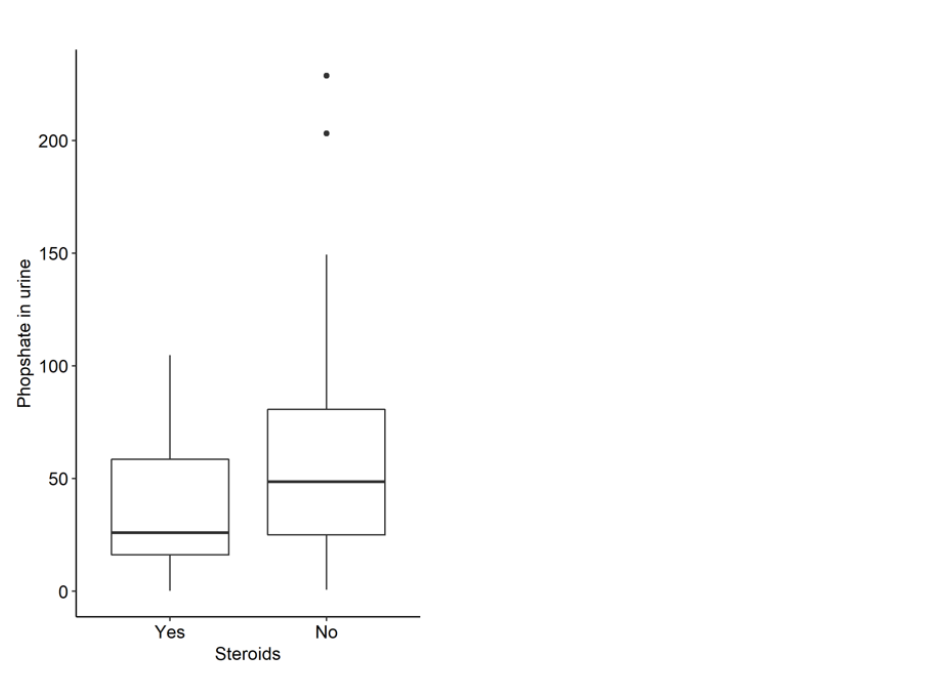
Figure 5. Urine phosphate levels in IBD patients with and without steroids ( p = 0.005). Higher levels of CTX were observed in the group of patients with UC who were being administered steroids (Table 3). Among the patients who were taking steroids (budeosonide and systemic steroids), there were no significant differences in the biochemical parameters between the groups (Table 9). Table 9. Differences between patients receiving budesonide and systemic steroids in the study group.